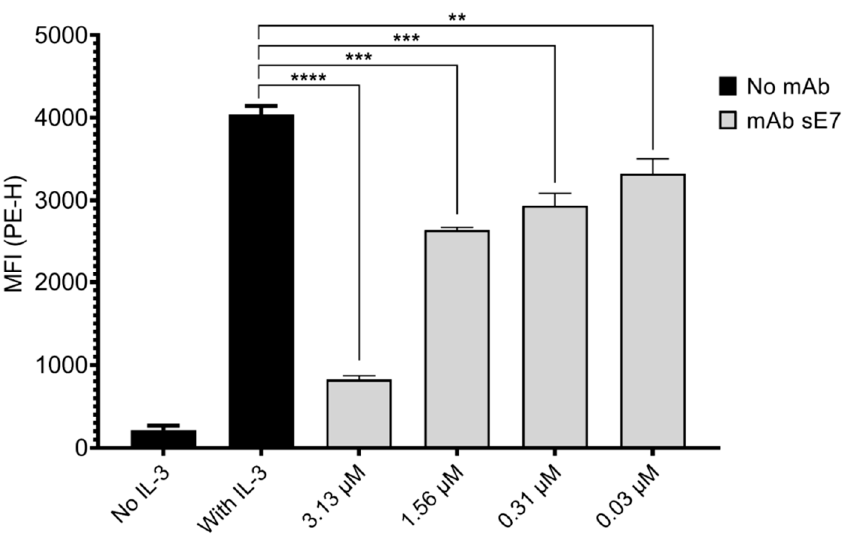
Figure 5. Flow cytometric analysis of pSTAT5 levels in NFS-60 cells following incubation with varying concentrations of mAb sE7 in response to mouse IL-3. Bars represent the mean fluorescence intensity (MFI) of PE after background (unstained cells) subtraction. Unstimulated cells or cells stimulated with 2 ng/mL of mIL-3 are shown as baseline and fully activated controls, respectively. The assay was performed in duplicate ( n = 2). Error bars represent the SD of two independent experiments. A One-Way ANOVA with a Tukey’s multiple comparisons test was performed to determine significance (**** p < 0.0001; *** p < 0.001; ** p < 0.01).